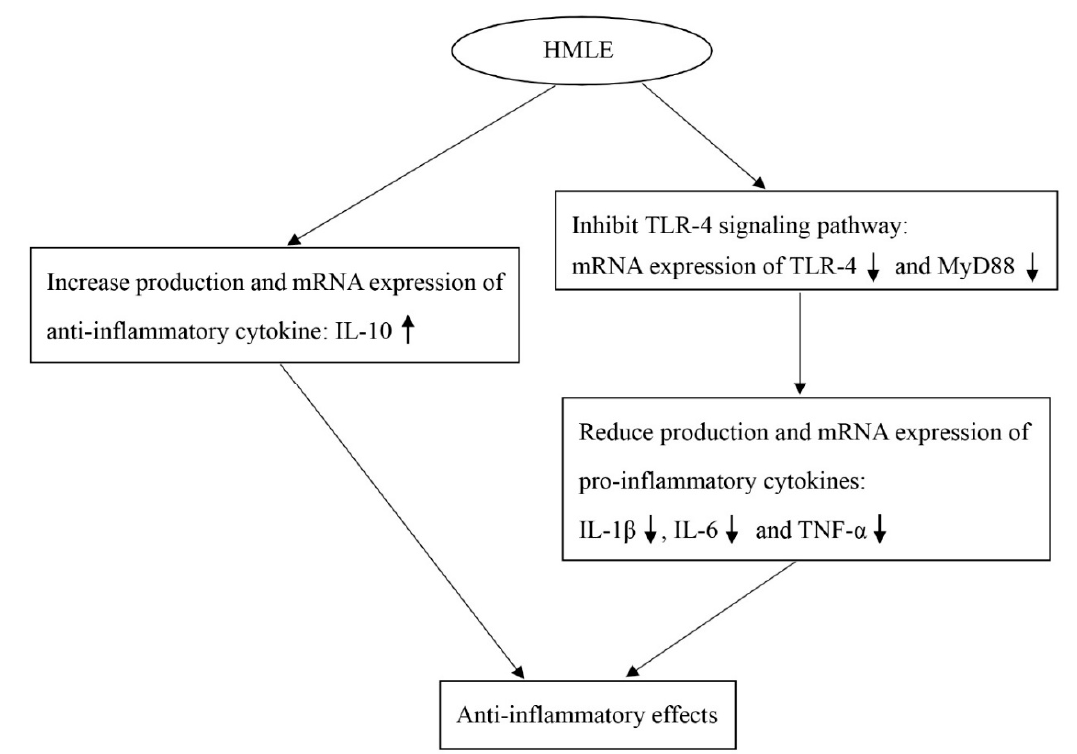
Figure 4. The potential mechanism of a protective effect of HMLE on intestinal morphology and barrier function after an injury induced by LPS using a mouse model (this model could also be applied to fish oils rich in n-3 long chain n-3 PUFA based on the current findings).